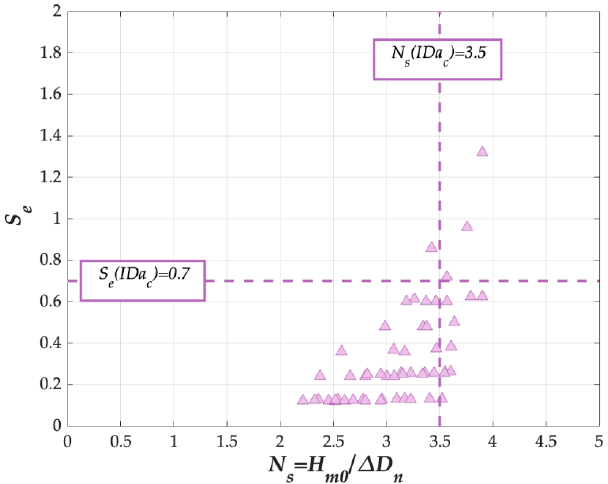
Figure 12. Armor damage to the crest of the Cubipod ® -armored model and IDa